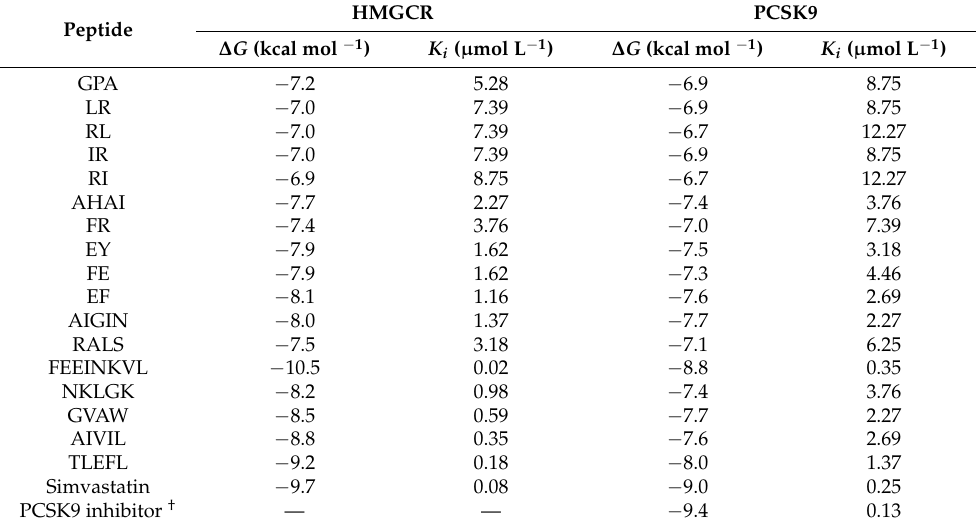
Table 2. Binding energy ( ∆ G ) and constant of interaction ( K i ) between 3-hydroxy-3-methylglutaryl- CoA reductase (HMGCR), proprotein convertase subtilisin/kexin type 9 (PCSK9), and the peptides identified in the selected soybean varieties digested under gastrointestinal conditions. Peptide